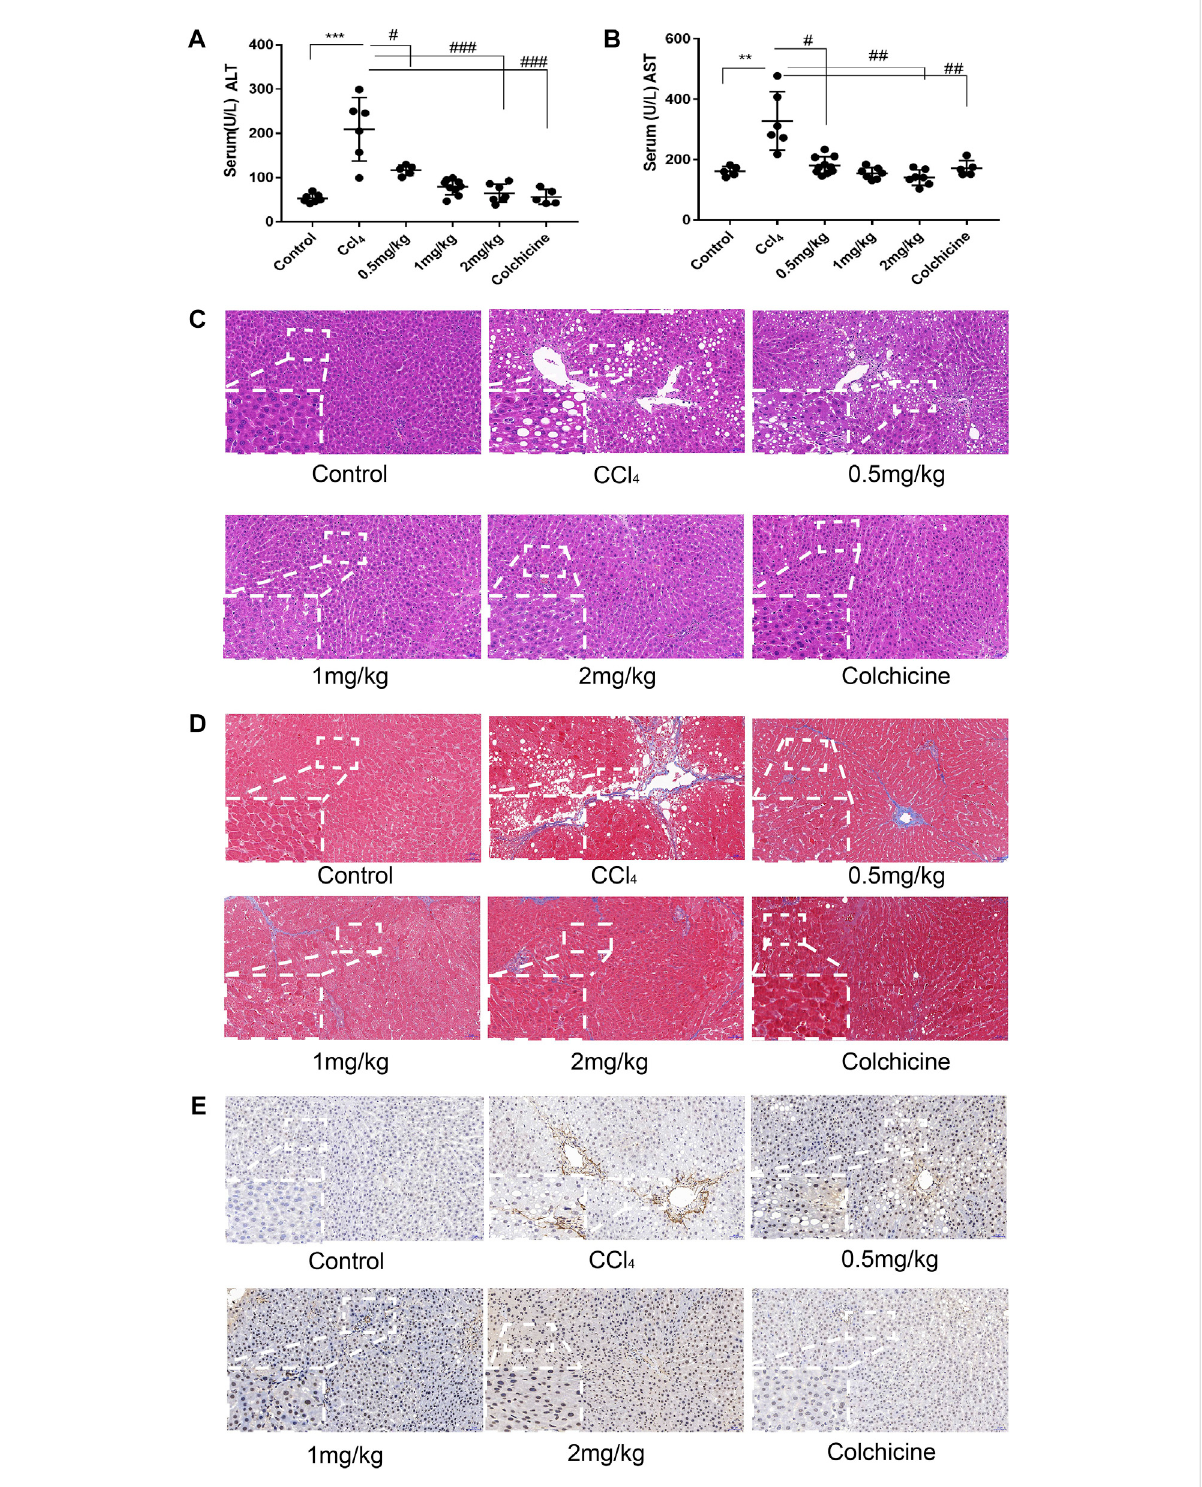
KN93 can improve ASIC1a regulation of HSC activation of proliferation and fi brosis. (A,B) Activities of alanine aminotransferase (ALT) and aspartateaminotransferase(AST)intheserumofrats. (C) HistopathologicalresultsofratlivertissuesstainedwithHEineachgroup(Scalebar,50